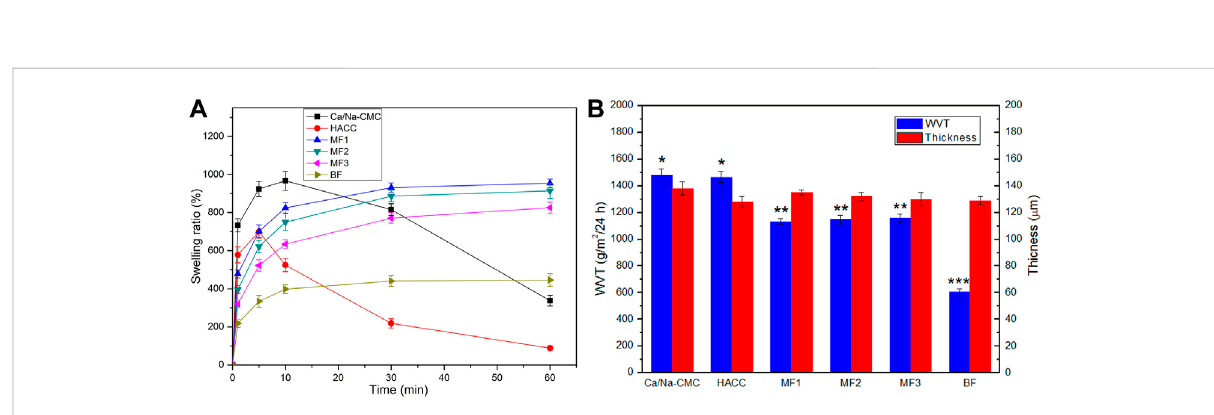
FIGURE 4 Swelling ratio (A) , WVT (B) and thickness (B) of Ca/Na-CMC fi lm, HACC fi lm, three multilayer fi lms (MF1-3) and BF. * p < 0.05 relative to MF1, MF2 or MF3. ** p < 0.05 relative to BF. *** p < 0.05 relative to CMC-Ca or